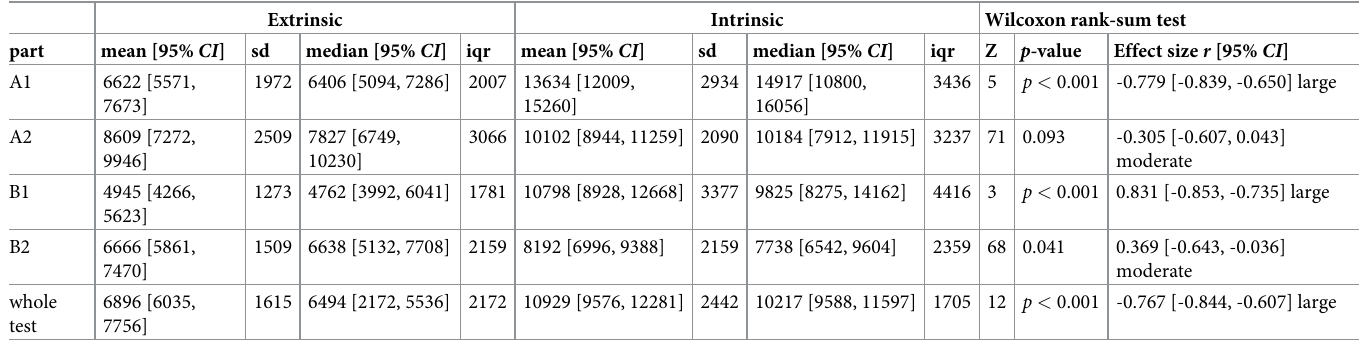
Table 1. Response times for the individual subtest parts (ms).